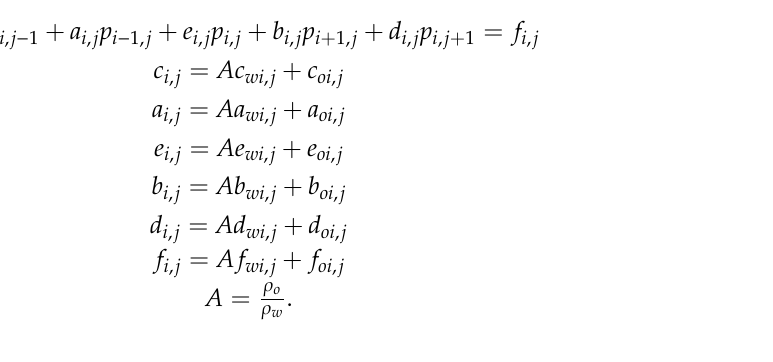
Figure 4. The polymer store rate’s change law of the Jinzhou 9-3 oilfield.